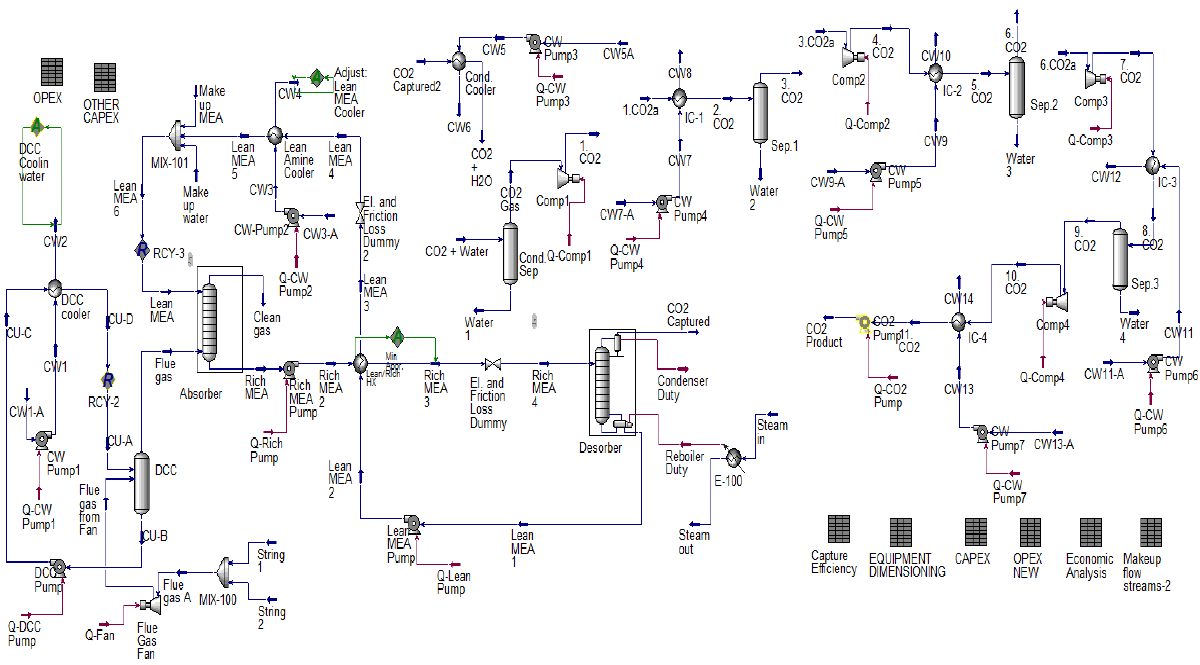
Figure A3. Aspen HYSYS simulations process flow diagram of the cement plant standard CO 2 capture process.